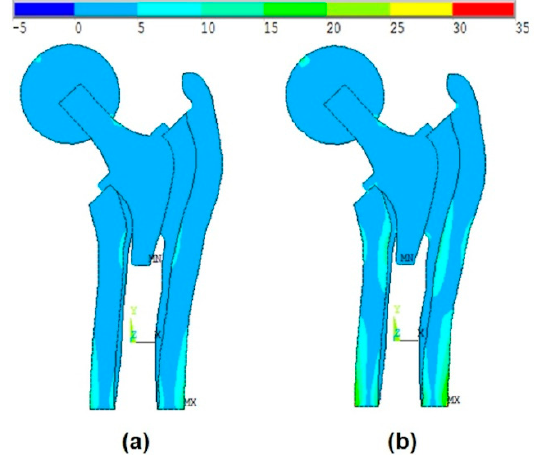
Figure 13. The effect of the introduction of the ball, bone anisotropy, and the stem shape optimization on the von-Mises stress distribution at ( a ) the optimal point and ( b ) the failure point.